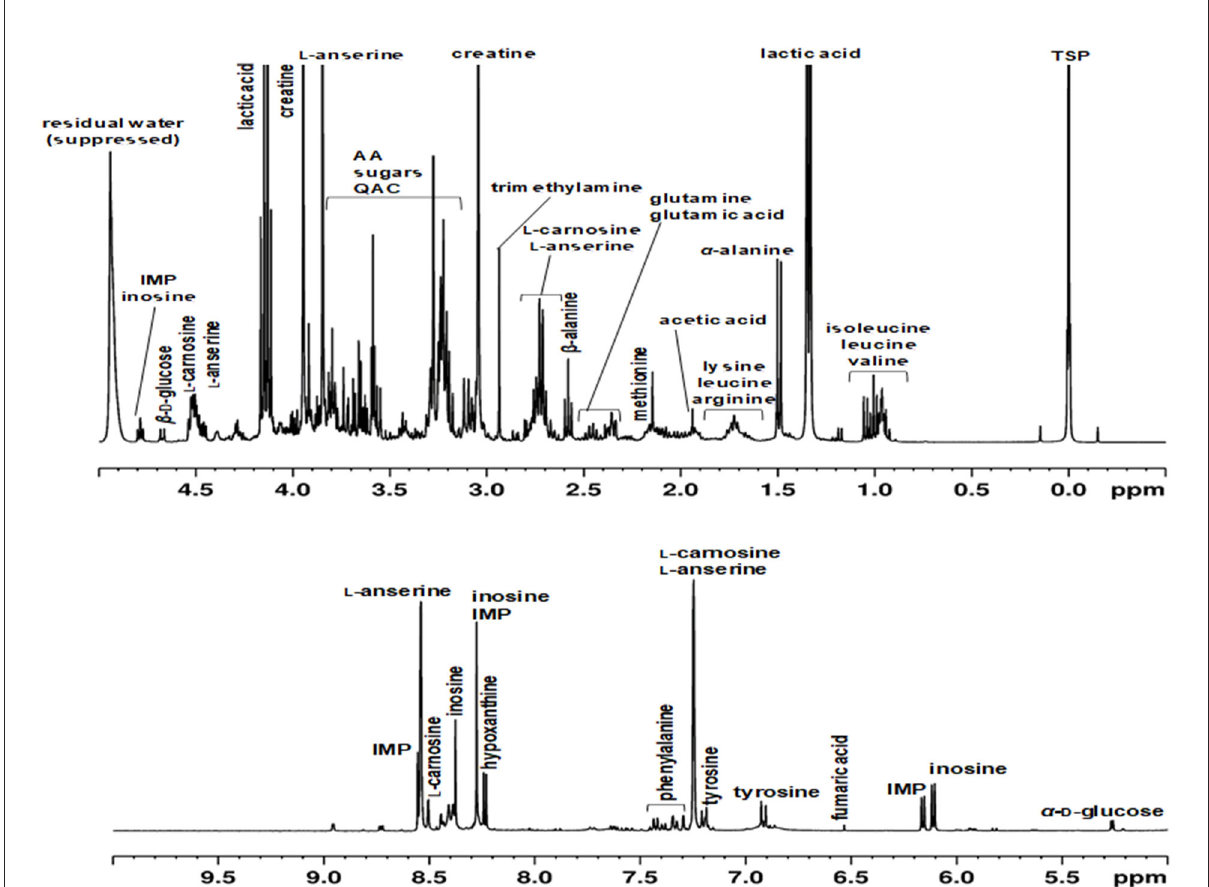
FIGURE2 Representative 1 H NMR spectra of an aqueous extract of a meat sample (poultry) recorded in H 2 O/D 2 O (10:1, v/v) using a 400 MHz spectrometer. Chemical shifts were calibrated against the TSP signal at 0 ppm. The residual water signal (4.84–5.10 ppm) was suppressed using the noesygppr1d_d7.eba experiment. IMP, inosine monophosphate; AA, amino acids; QAC, quaternary ammonium